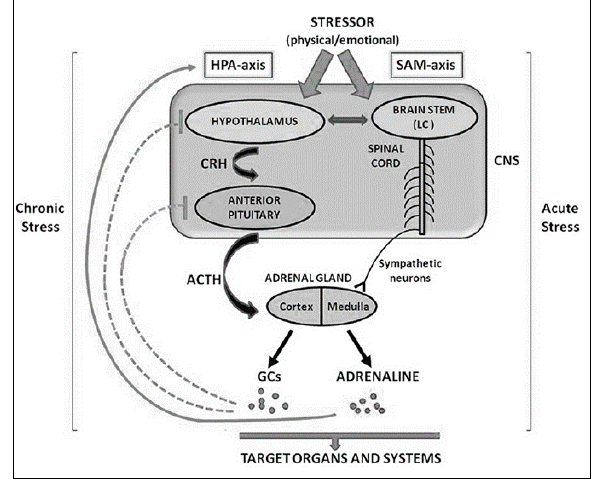
Figure 1: Schematic representation of the actions of the hypothalamic- pituitary-adrenal (HPA) and sympathetic-adrenal-medullary (SAM) axes in the regulation of the stress response.